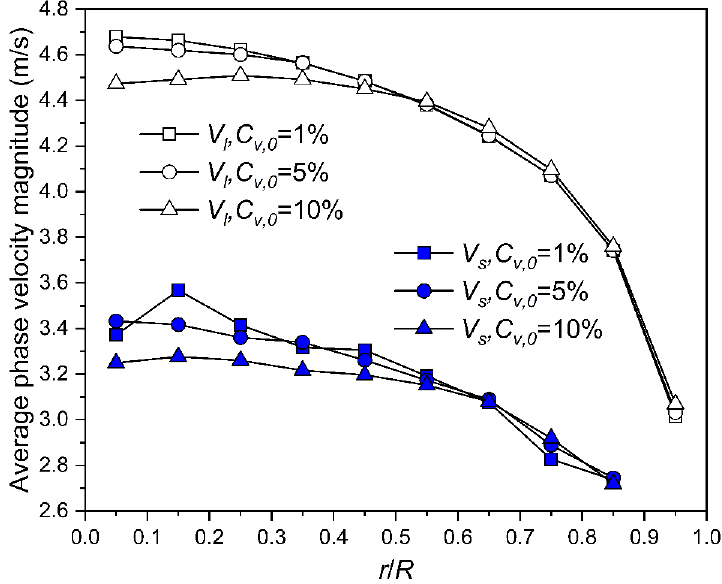
Figure 6. Effects of initial SVF on average phase velocities ( V mix ,0 = 4.0 m/s, d s = 15.0 mm).